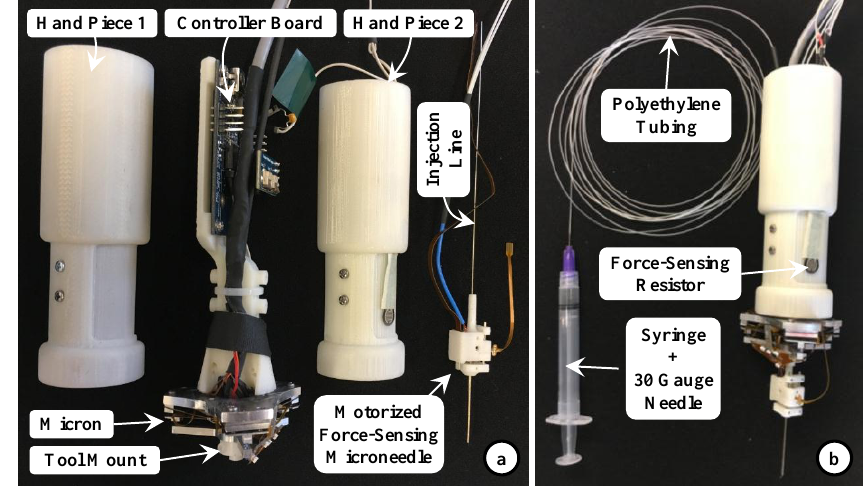
Figure 7. Sample integration of the motorized force-sensing microneedle with a handheld micromanipulator, Micron. ( a ) The controller board for the tool’s motor was located on Micron’s handle inside the two hand pieces; ( b ) A force-sensing resistor was mounted on one of the hand pieces, under the operator’s thumb, to control the microneedle’s actuation by squeezing or releasing the hand piece. The injection line passes through the center of the instrument and is connected to a syringe via polyethylene tubing to deliver fluid to the microneedle.